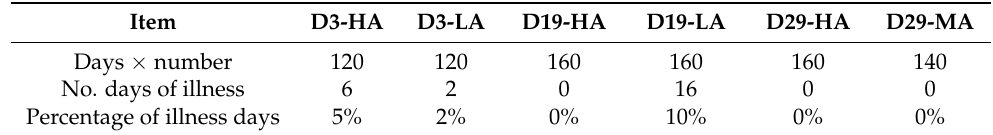
Table 8. Morbidity of calves during the experiment.